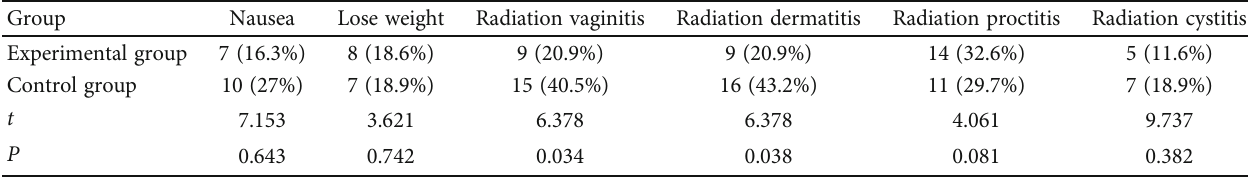
Table 4: Comparison of adverse reactions between two